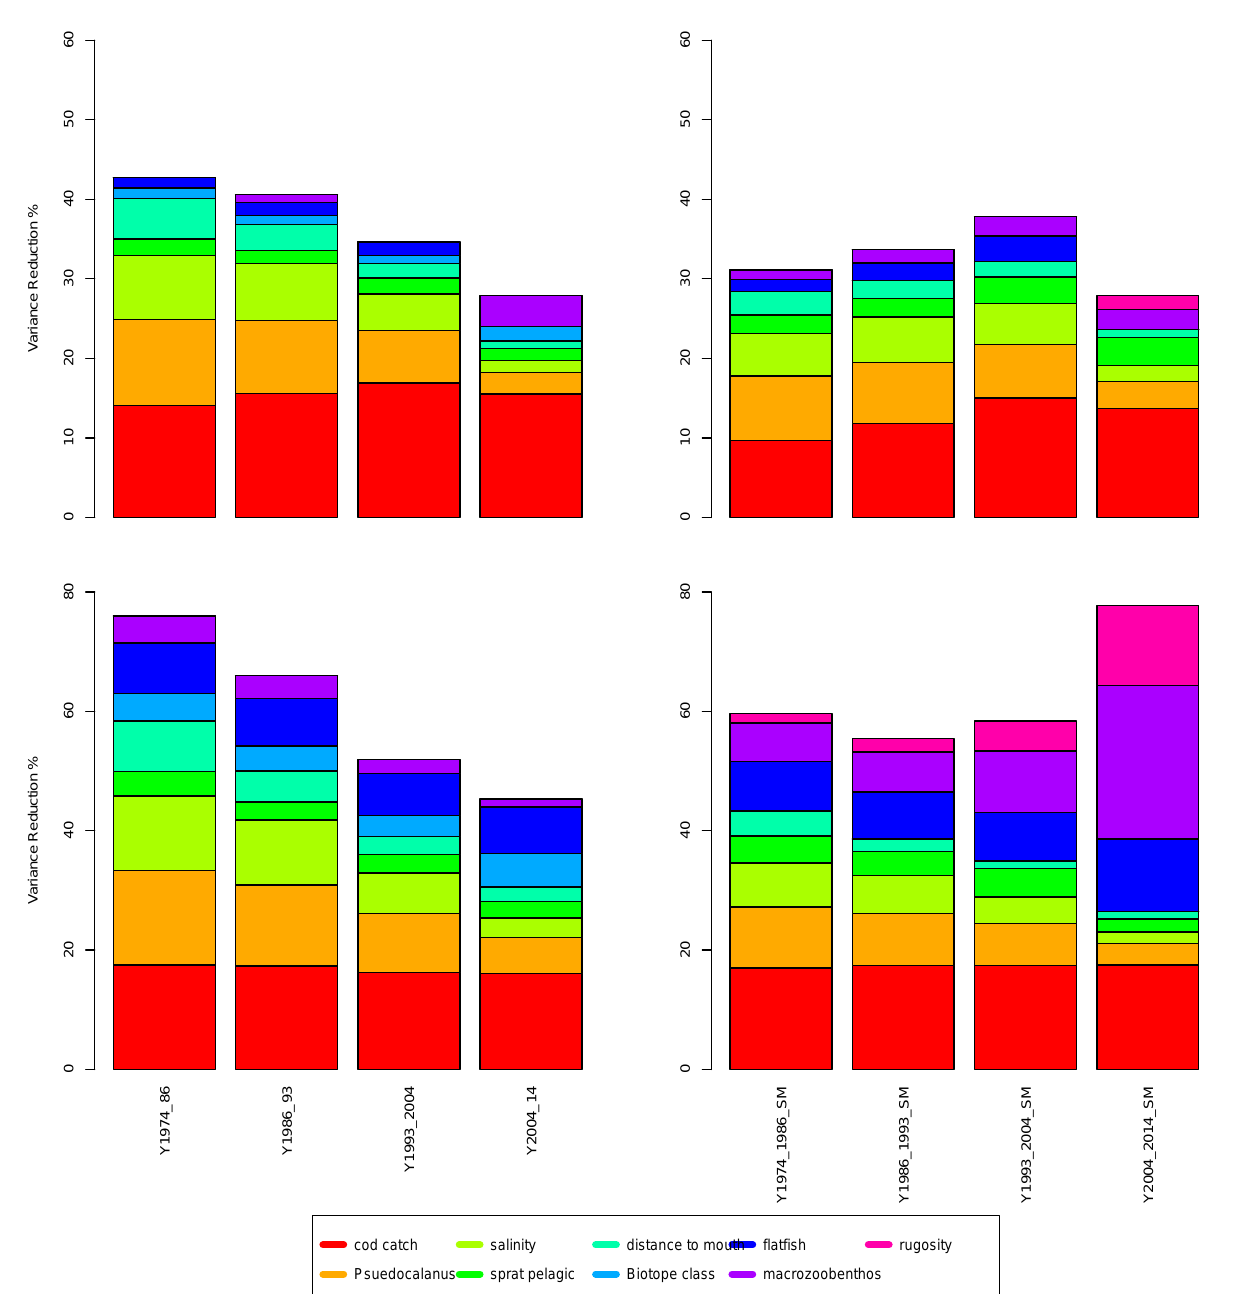
Figure 8. The magnitude of the dominant influential factors for time periods 1974, 1986, 1993, 2004, and 2014 for ICES 25 ( top ) and 28 ( bottom ) without biotope information ( left ) and with biotope information ( right